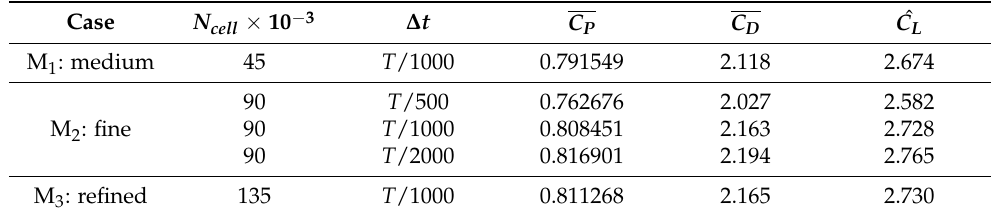
Table 1. Comparison of time average force and power coefficients for different mesh sizes and time- step sizes (number of cells ( N cell ) was rounded-off).